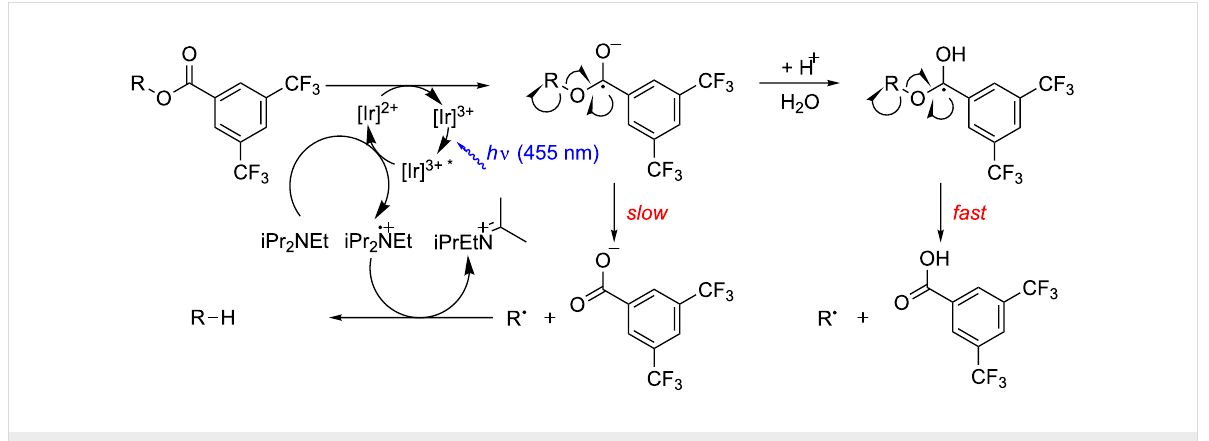
Scheme 4: Proposed reaction mechanism with and without additional water.